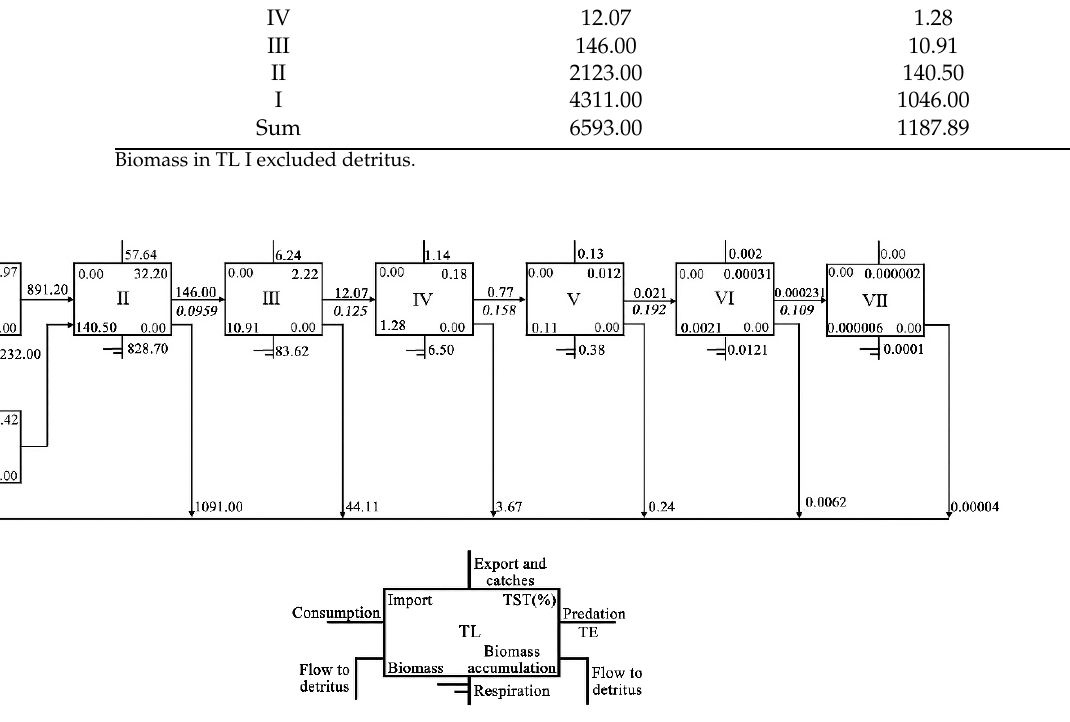
Figure 4. Energy flows among different trophic levels in the culture system. P: primary producer; D: